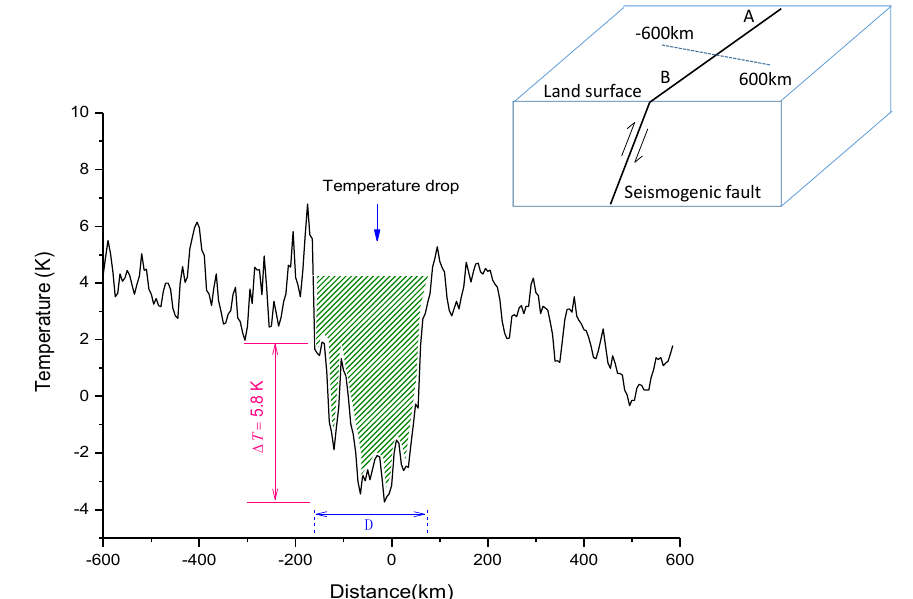
Figure 5. The spatial profile of co-seismic land surface temperature perpendicular to the seismogenic fault (AB) of the 2008 Mw 7.9 Wenchuan earthquake obtained by satellite (Revised from [50]. Note: the background land surface temperature was abstracted).